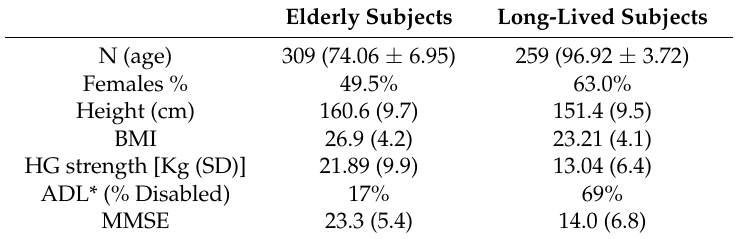
Table 1. General characteristics and post-survey mortality in the analyzed